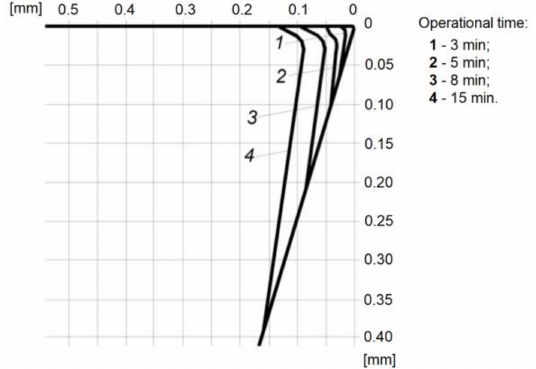
Figure 14. Profilograms of the development of wear on the working surfaces of the Al 2 O 3 + SiC ceramic insert with the DLC over time.